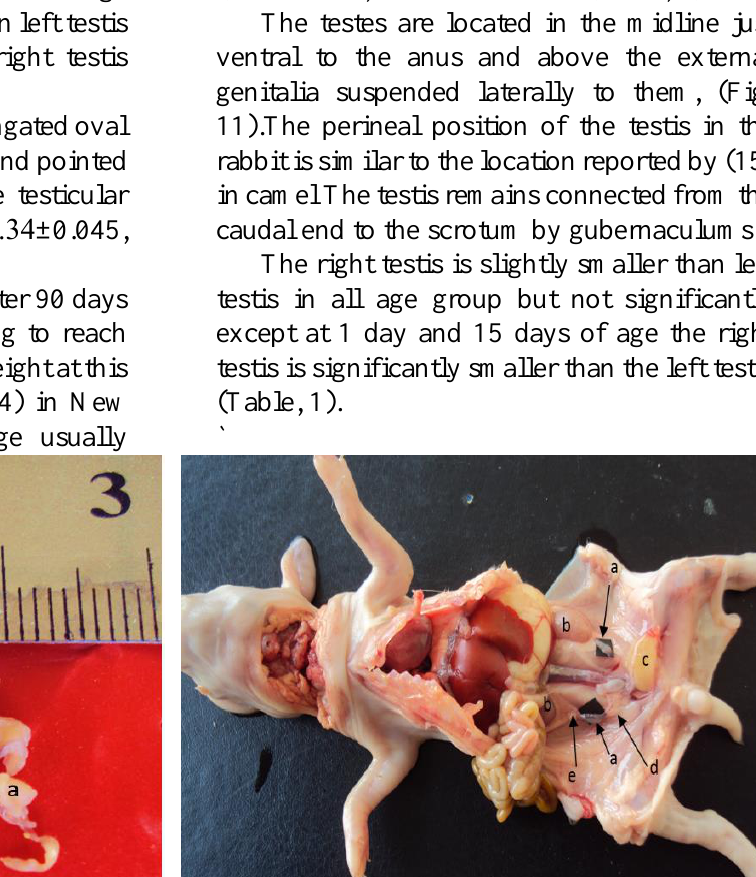
Figure, 2: shows the shape and position of testis in situ in the Kit rabbit at 1- day age a-testis b- kidney c- urinary bladder d- gubernaculum e- cranial suspensory